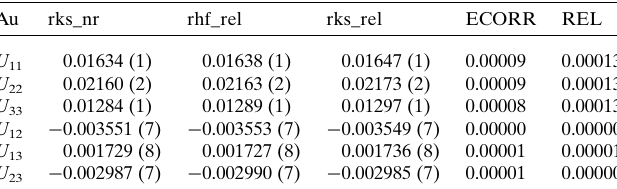
Table 4 The difference between gold ADPs (A˚ 2 ) obtained from rks_nr, rhf_rel and rks_rel, representing the effects of electron correlation (rks_rel – rhf_rel) and relativity (rks_rel – rks_nr) for SP8 data. Au